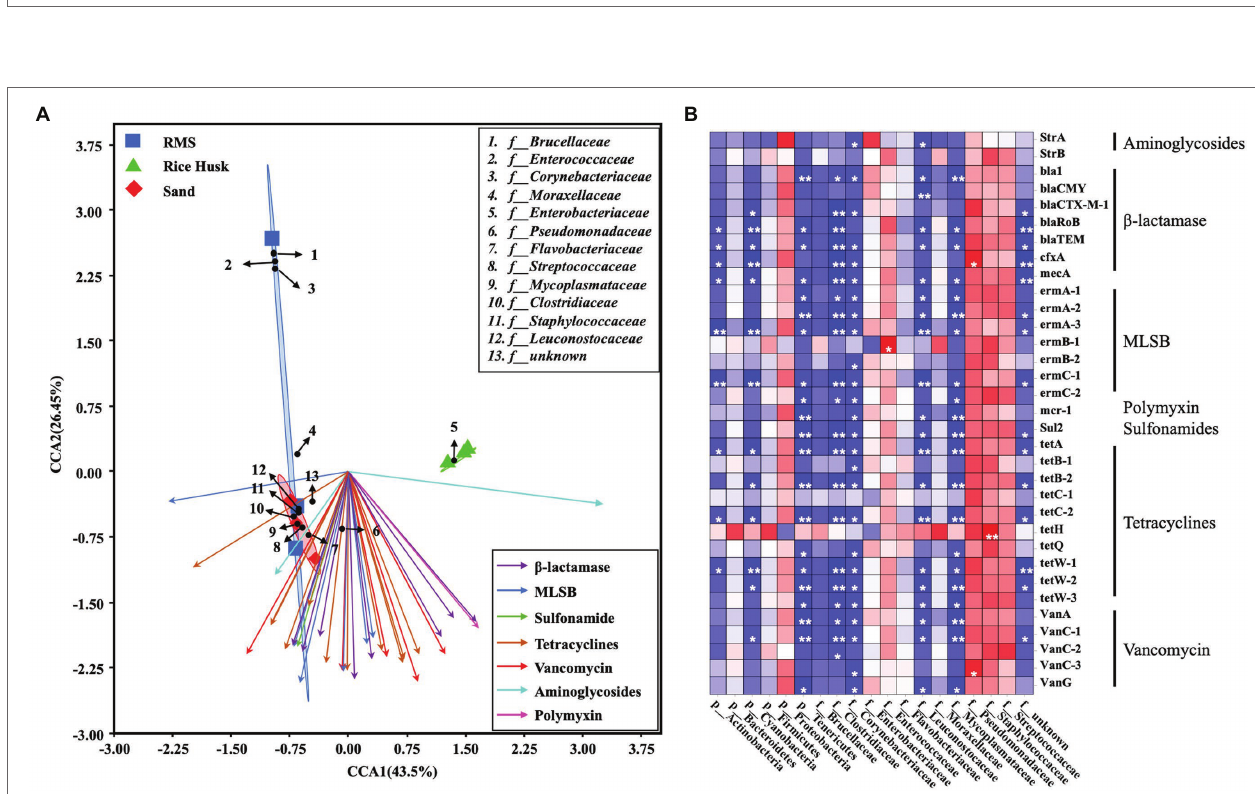
FIGURE 2 | Detection proportion of ARGs detected in raw milk from different beddings. Data were described using mean ± SD. * p < 0.05; ** p < 0.01; *** p ≤ 0.005; and **** p ≤